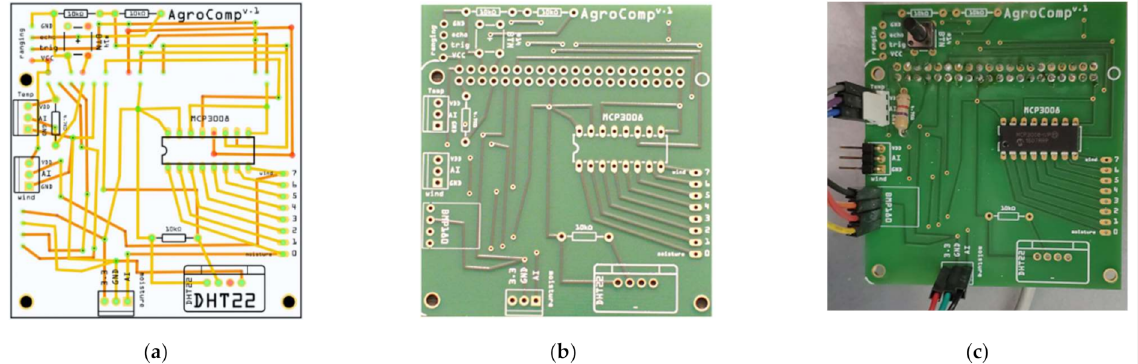
Figure 4. The expansion board (Hat) developed for the RPi: ( a ) PCB schematic on the left, ( b ) Drilled PCB in the center, and ( c ) final Hat